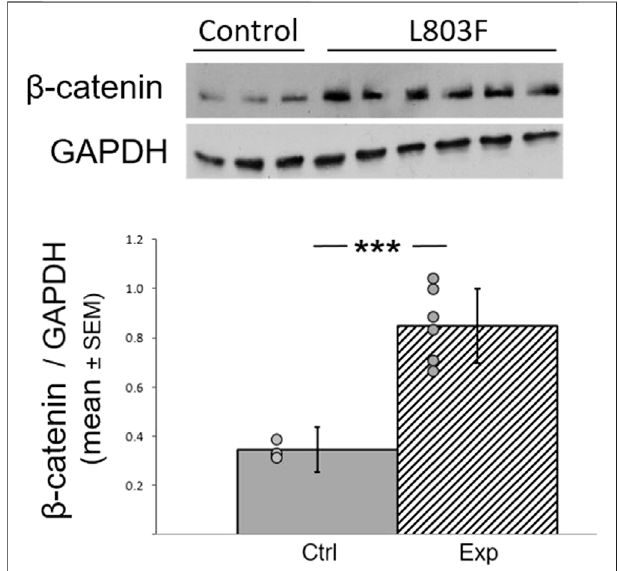
FIGURE 4 | L803Fmts inhibits GSK-3 β in the adult avian hippocampus. Femalezebra fi nchesweretreatedwithL803Fmtsandcomparedtountreated controls. Brain tissue from the hippocampus was subjected to western blot analyses using GAPDH and β -catenin antibodies. Ratios of β -catenin to GAPDH from densitometry analyses are shown below the gel image. Results are means (±SEM) for control ( n = 3) and L803Fmts treated birds ( n = 6). Individual dots indicate the value of each sample. *** p <